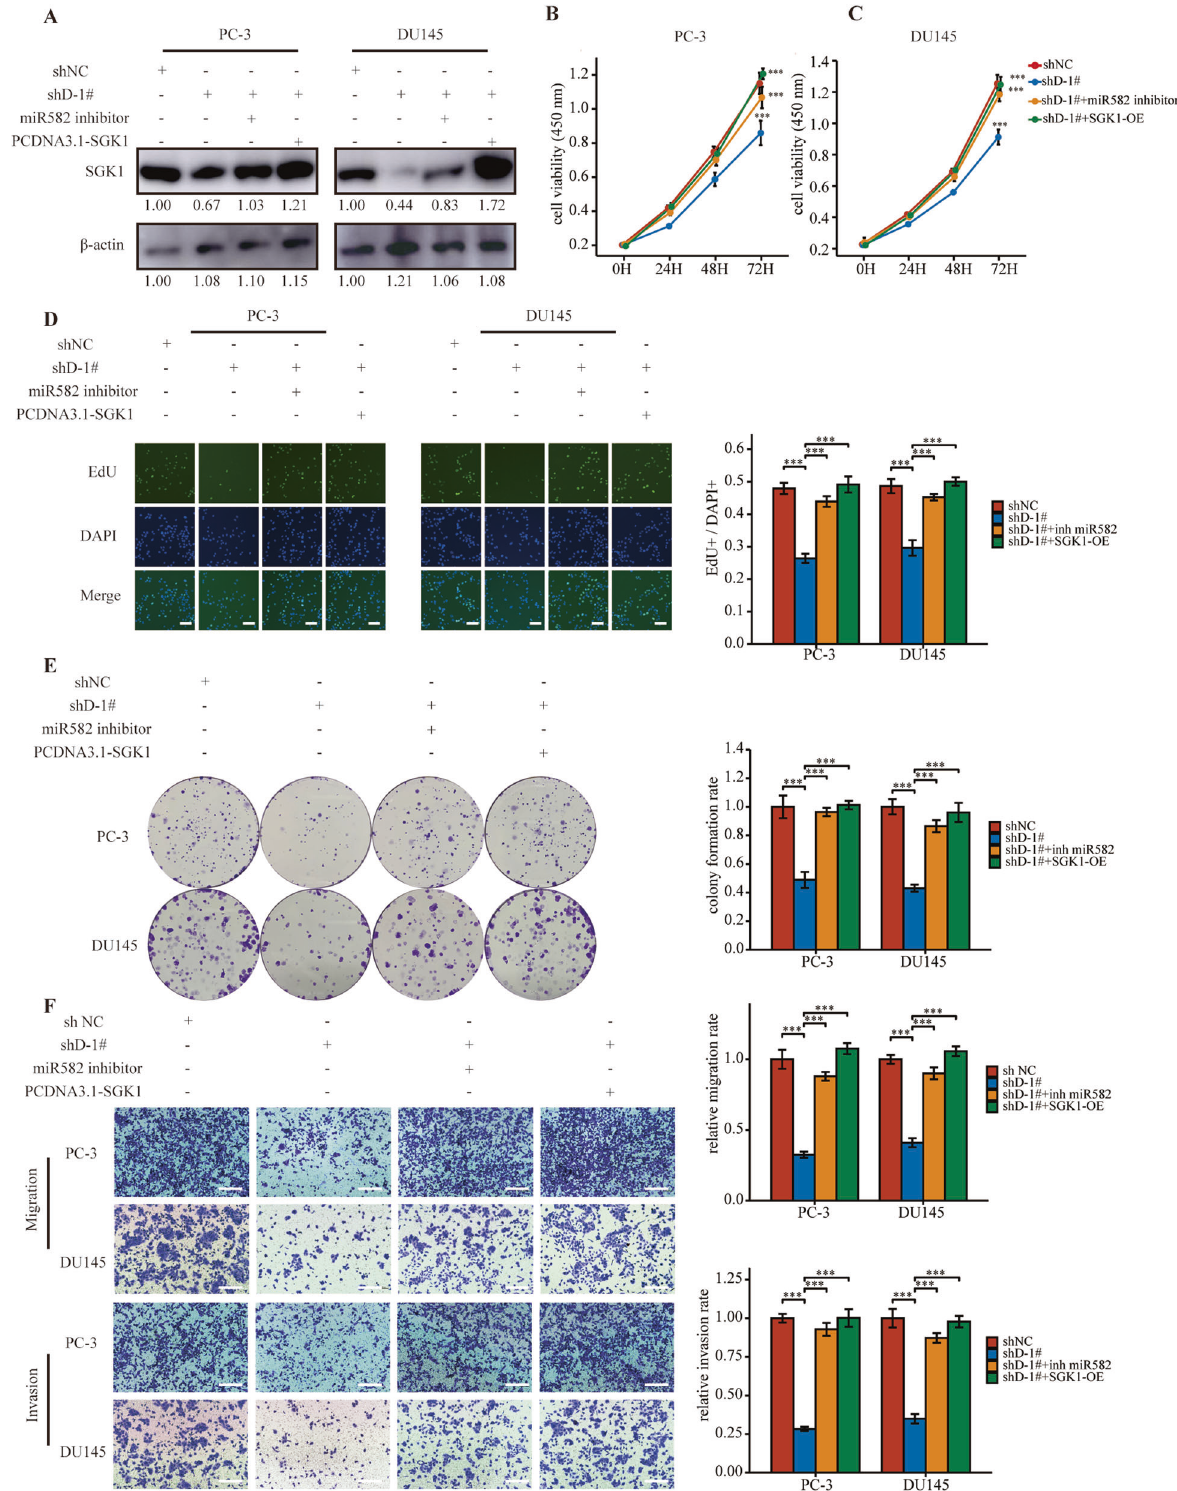
Fig. 5 DLEU2 effected prostate cancer progression via the miR-582-5p/SGK1 axis. A Western blot analysis of SGK1 expression in DLEU2 knockdown PC-3, DU145 cells transfected with miR582-5p inhibitor or SGK1 overexpression vector. B , C The cell viability of PC-3 and DU145 cells as described above. D Result of EdU assay showing the cell proliferation in PC-3 and DU145 cells as described above (scale bar: 50 μ m). E The colony formation analysis of PC-3 and DU145 cells as described above. F The migration and invasion analysis of prostate cancer cells as described above (scale bar: 50 μ m). Data were indicated as mean ± SD, ns P ≥ 0.05, * P < 0.05, ** P < 0.01, *** P < 0.001.